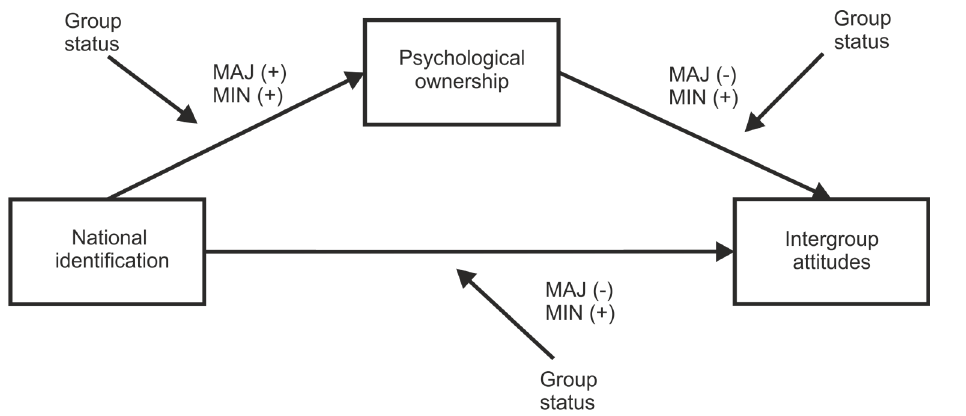
Figure 1. The proposed model of the relationship between national identification and intergroup attitudes moderated by group status (majority vs. minority). MAJ = Finns; MIN =